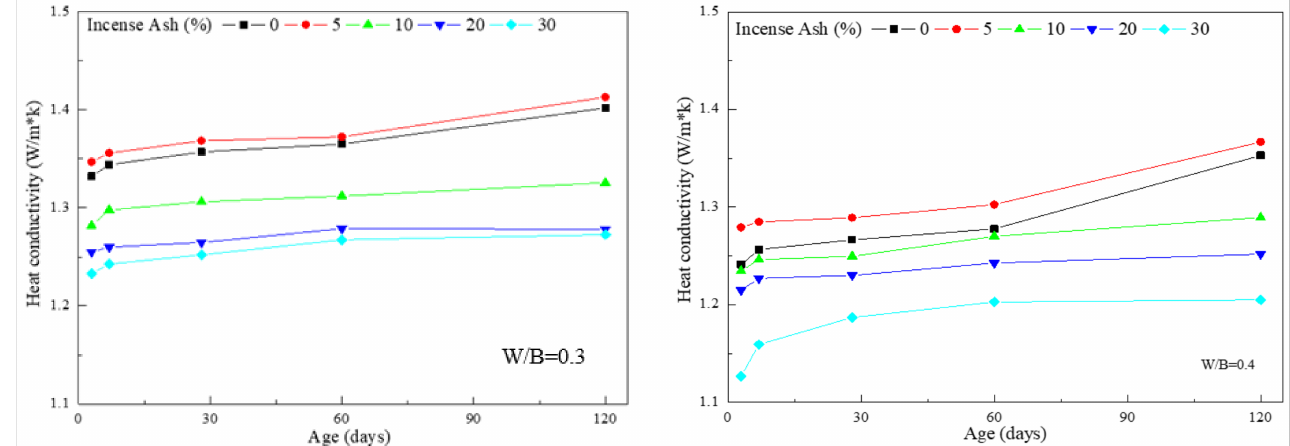
Figure 5. Thermal conductivity developments of incense ash